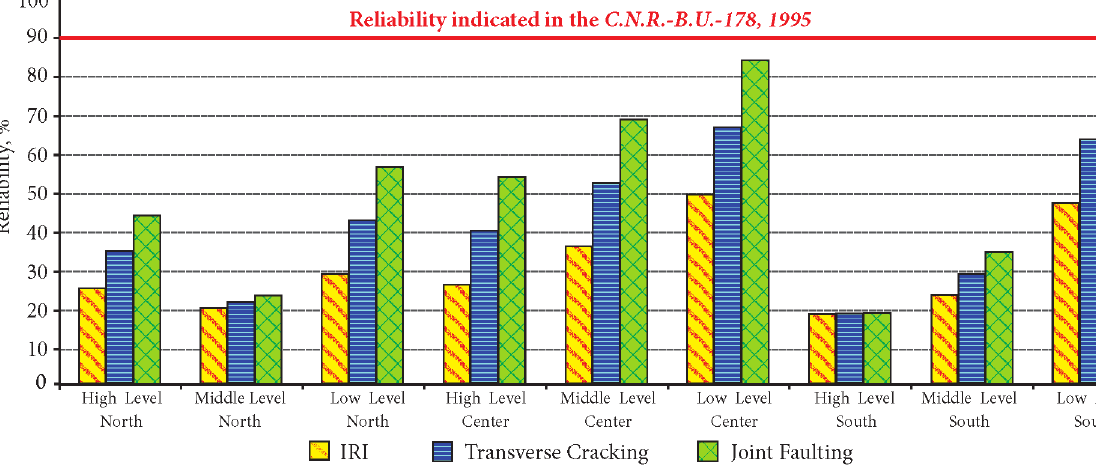
fig. 10. Decay of the pavement – freeway/rigid pavement after 20 years